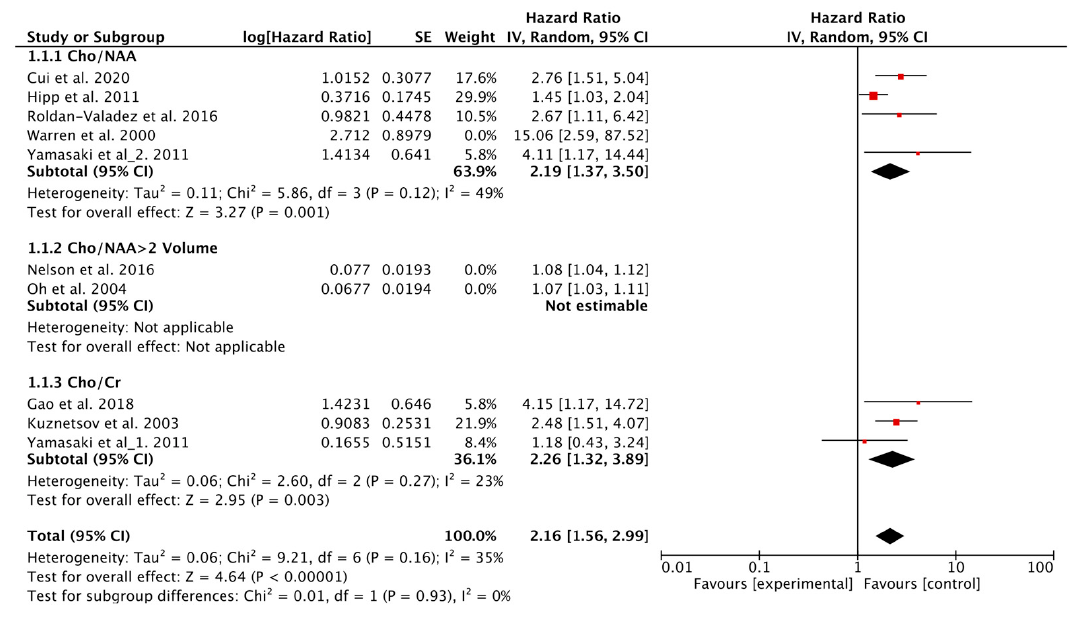
Figure 2 . Forest plots of the pooled hazard ratio for OS of choline. Figure 2. Forest plots of the pooled hazard ratio for OS of choline.